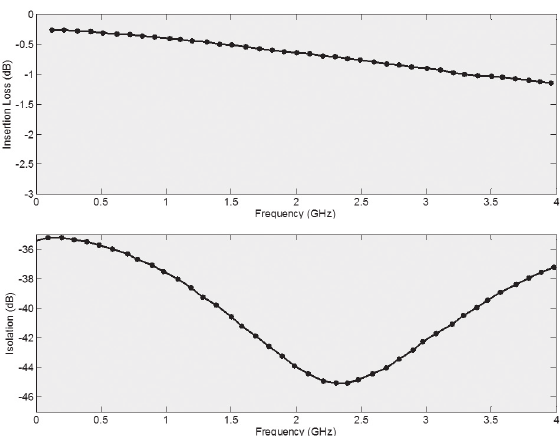
Figure 5 - Insertion loss and isolation performance of the switch.